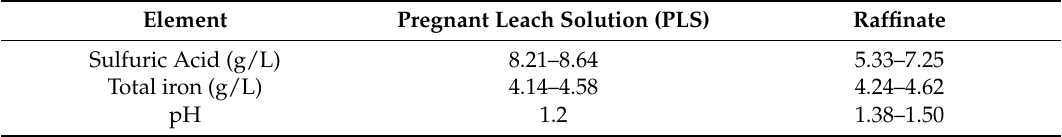
Table 5. Chemical composition of feed solutions.